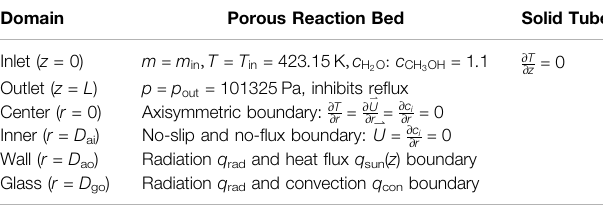
TABLE 2 | SPTR model boundary conditions. Domain Porous Reaction Bed Solid